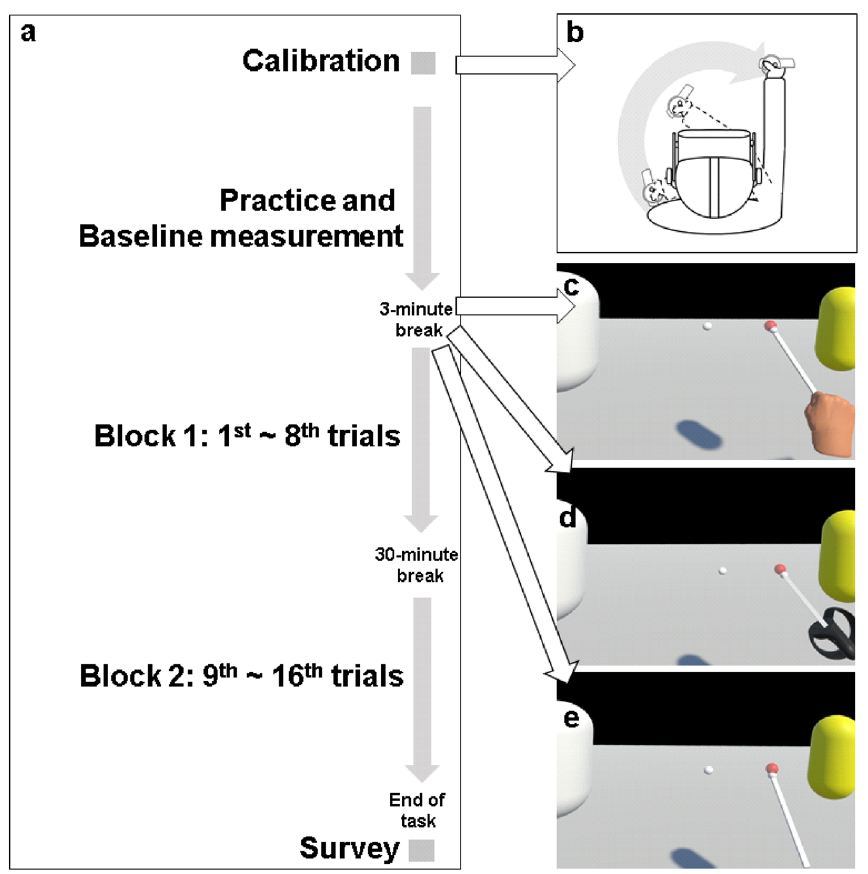
Figure 3. Experimental procedure and conditions. ( a ) Experimental procedure: after calibrating the positioning the target, considering each participant’s shoulder height and arm length, the participants conducted three practice trials—a baseline measurement trial, and sixteen main trials. During a 3-min break after the baseline measurement, participants could see and adapt to their changed avatar according to their assigned experimental conditions. To measure the retention of procedural memory, eight trials were followed by a 30-min break before the remaining eight trials were conducted. At the conclusion of the VRRP task, participants completed a questionnaire on body-ownership and sense of agency. ( b ) The movement for the calibration. ( c ) Experimental condition: hand-shaped avatar. ( d ) Experimental condition: control object-shaped avatar. ( e ) Experimental condition: